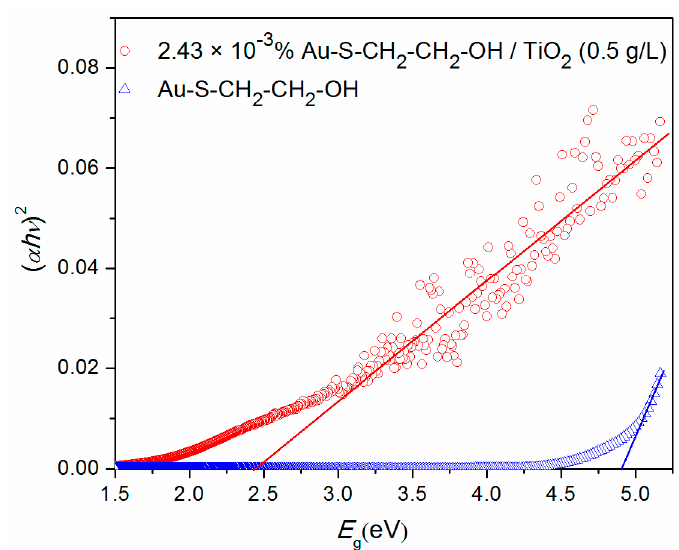
2 )( να h Figure 4. Modified absorbance ( α h ν ) 2 plotted vs. the energy h ν for the samples 2.43 × 10 − 3 % Figure 4. Modified absorbance plotted vs. the energy h ν for the samples 2.43 × 10 − 3 % Au–S–CH 2 –CH 2 –OH / TiO 2 (0.5 g / L) (red circles) and Au–S–CH 2 –CH 2 –OH (blue triangles). The colored Au–S–CH 2 –CH 2 –OH/TiO 2 (0.5 g/L) (red circles) and Au–S–CH 2 –CH 2 –OH (blue triangles). The lines are the linear extrapolations show the band gap colored lines are the linear extrapolations show the band gap energies.